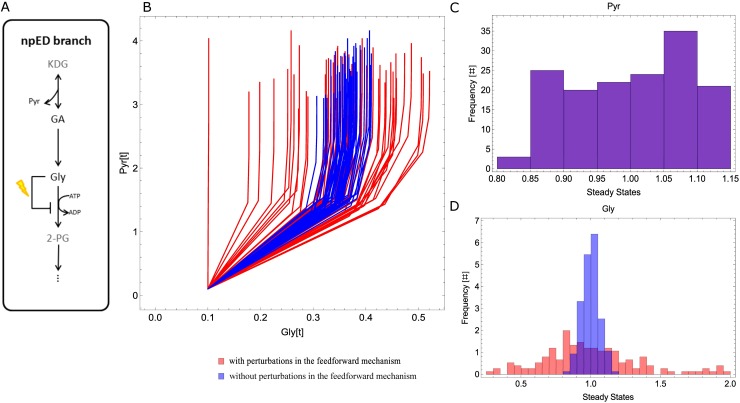
Perturbation of the negative feedforward reaction of the npED branch.Stochastic perturbations on the feedforward parameters affecting VGK. A) Pathway diagram of the npED branch with perturbation on the feedforward connection; B) Parametric plot relating Pyr and Gly with feedforward perturbations (red) and without feedforward perturbations (blue); C) Histogram of Pyr steady states with feedforward perturbations (red) and without feedforward perturbations (blue); D) Histogram of Gly steady states with feedforward perturbations (red) and without feedforward perturbations (blue).